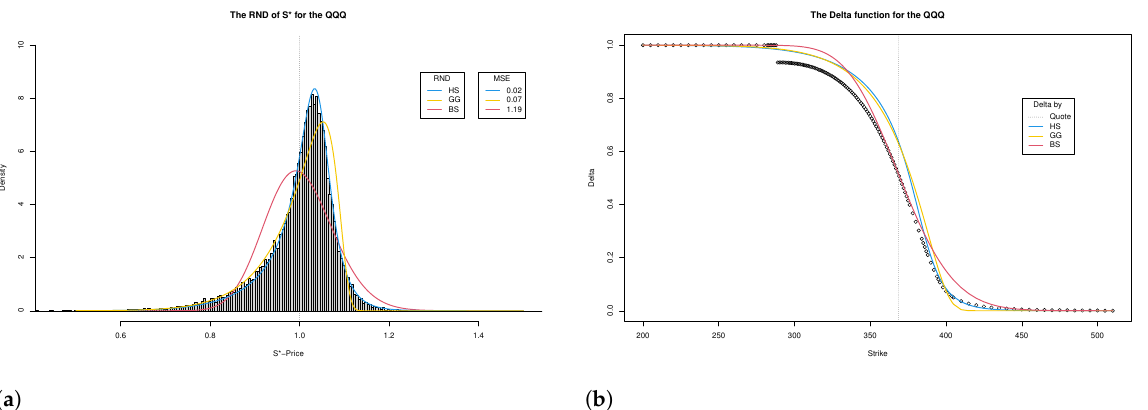
Figure 5. The QQQ case: ( a ) the HS, GG and BS implied RNDs along with the Monte Carlo distribution of the Spot’s price S ∗ , and ( b ) the corresponding delta functions along with the quoted delta per each strike K in the option series.